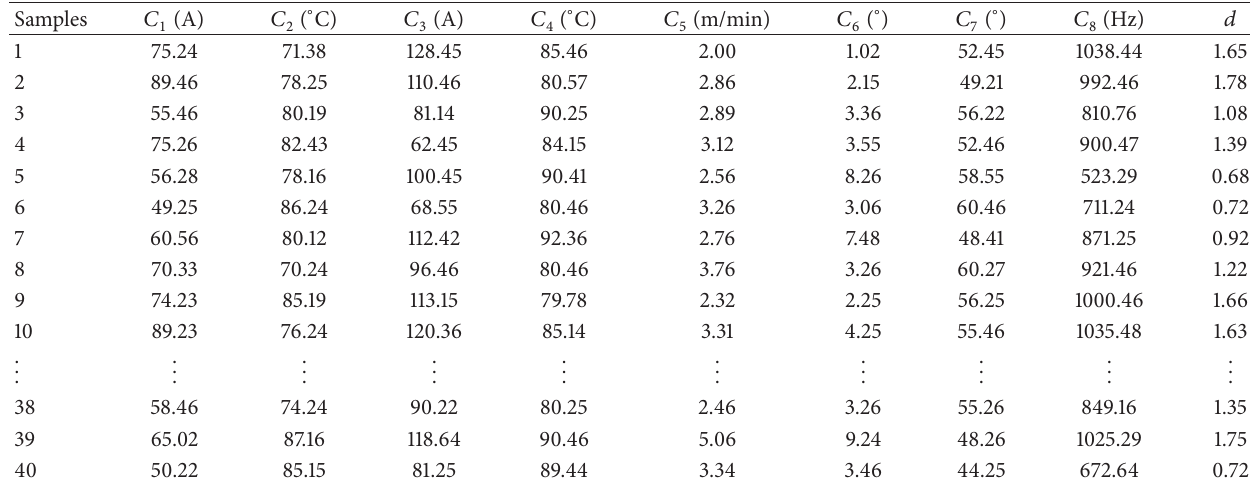
Table 4: The testing samples for the classifier.